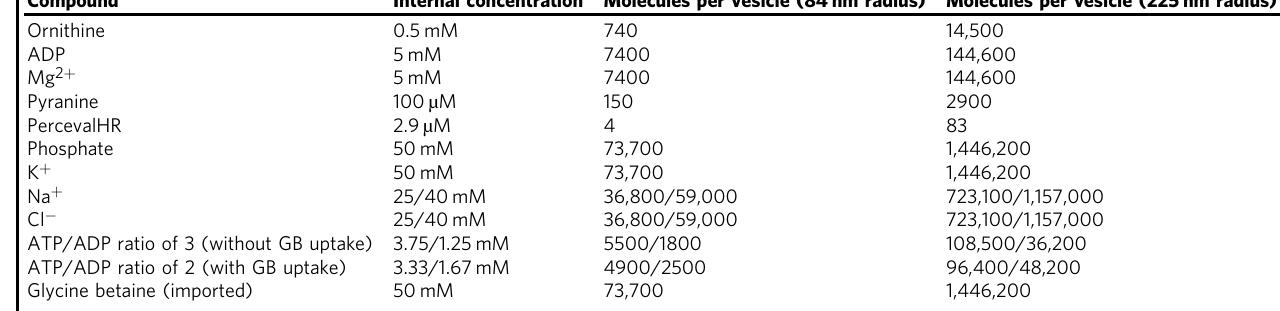
Table 2 Average number of molecules per vesicle